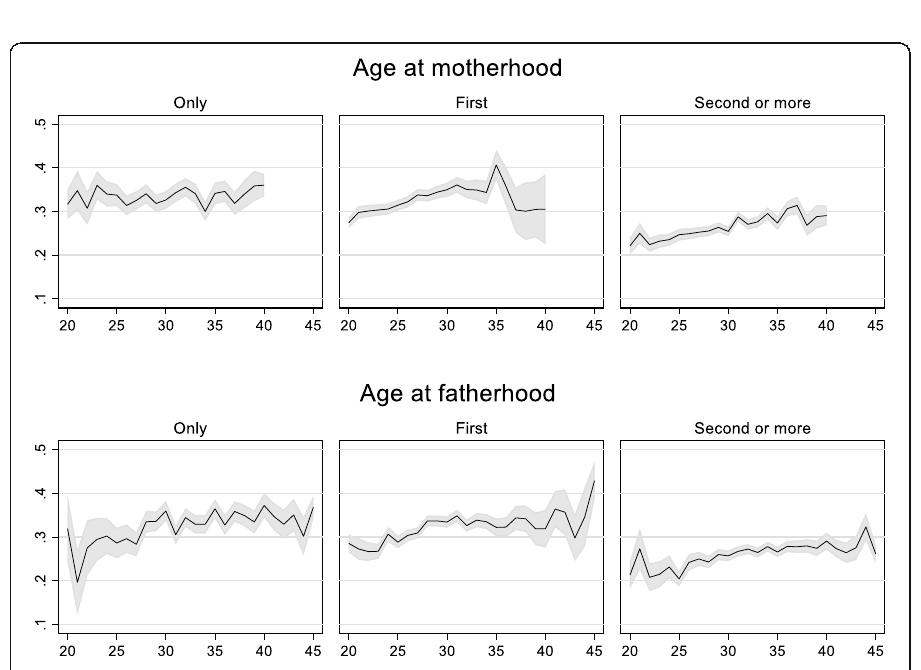
Fig. 6 Mother ’ s and father ’ s age at childbirth and probabilities of being enrolled in the academic track, by birth order. Figures show the average linear predictions (with 95% confidence intervals), from linear probability models with robust standard errors. Models control for both parents ’ social class and education, region of residence, trimester-year of interview, birth abroad, age and